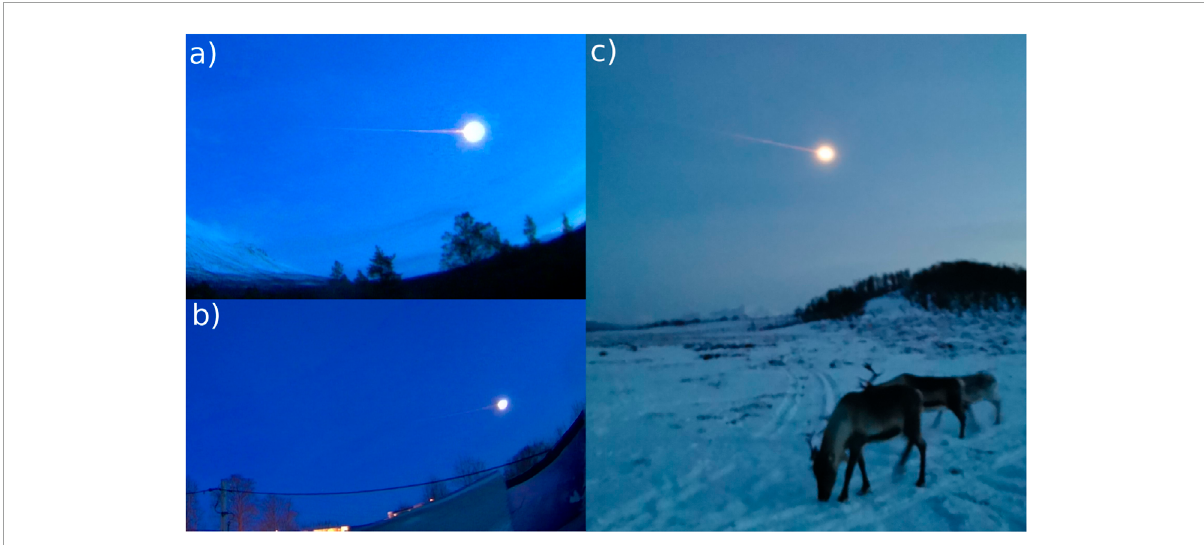
FIGURE 2 On the left, video camera stills of the fireball from two observing stations at 2020-12-04 13:30:42 UTC. The view from Skibotn is shown above (A) and the view from Sørreisa is shown below (B) . On the right, there is an image (C) of the fireball taken by John M. Oskal in Sørreisa using a smartphone camera.